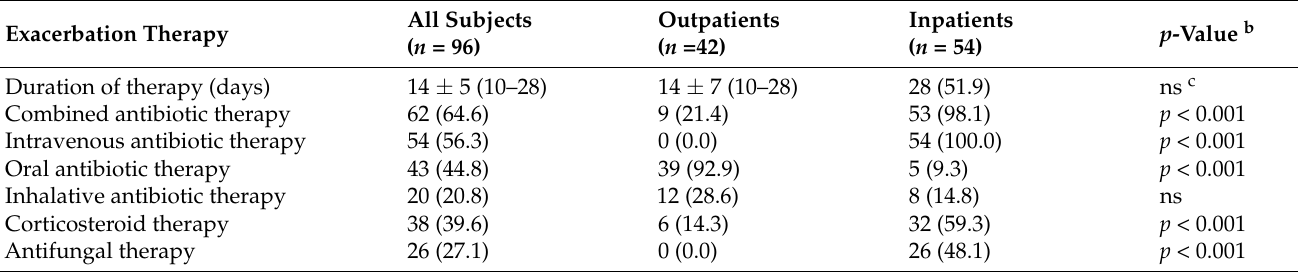
Table 2. BEx treatment. Type of therapy, total numbers, and percentages of inpatients and